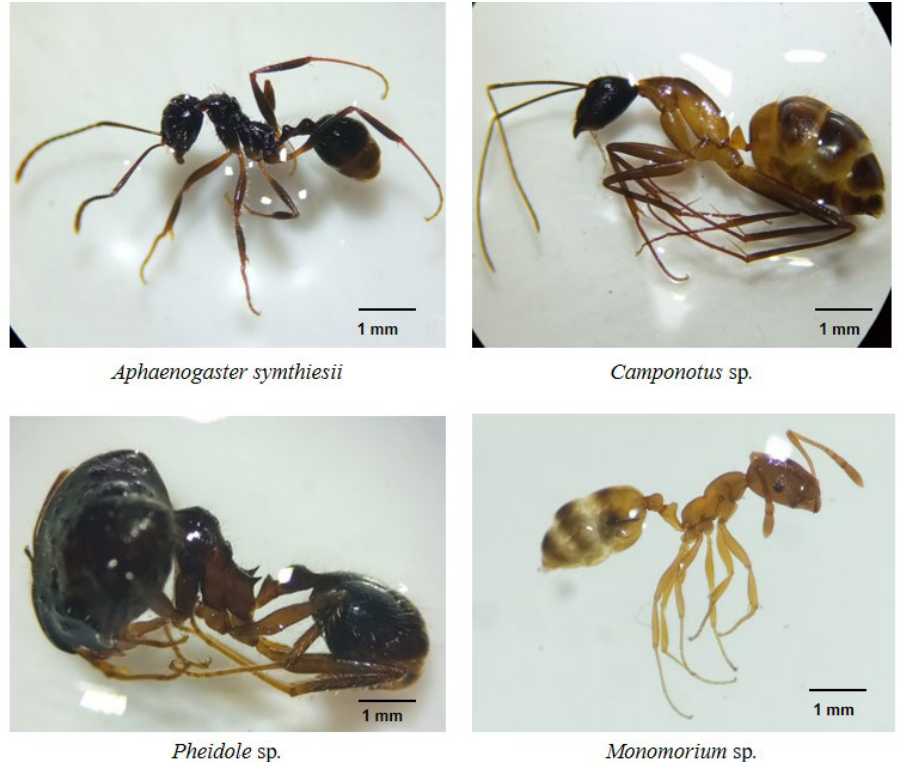
Figure 9. Major ant species present in the diet of Chinese pangolins in Chandragiri Municipality, Nepal.